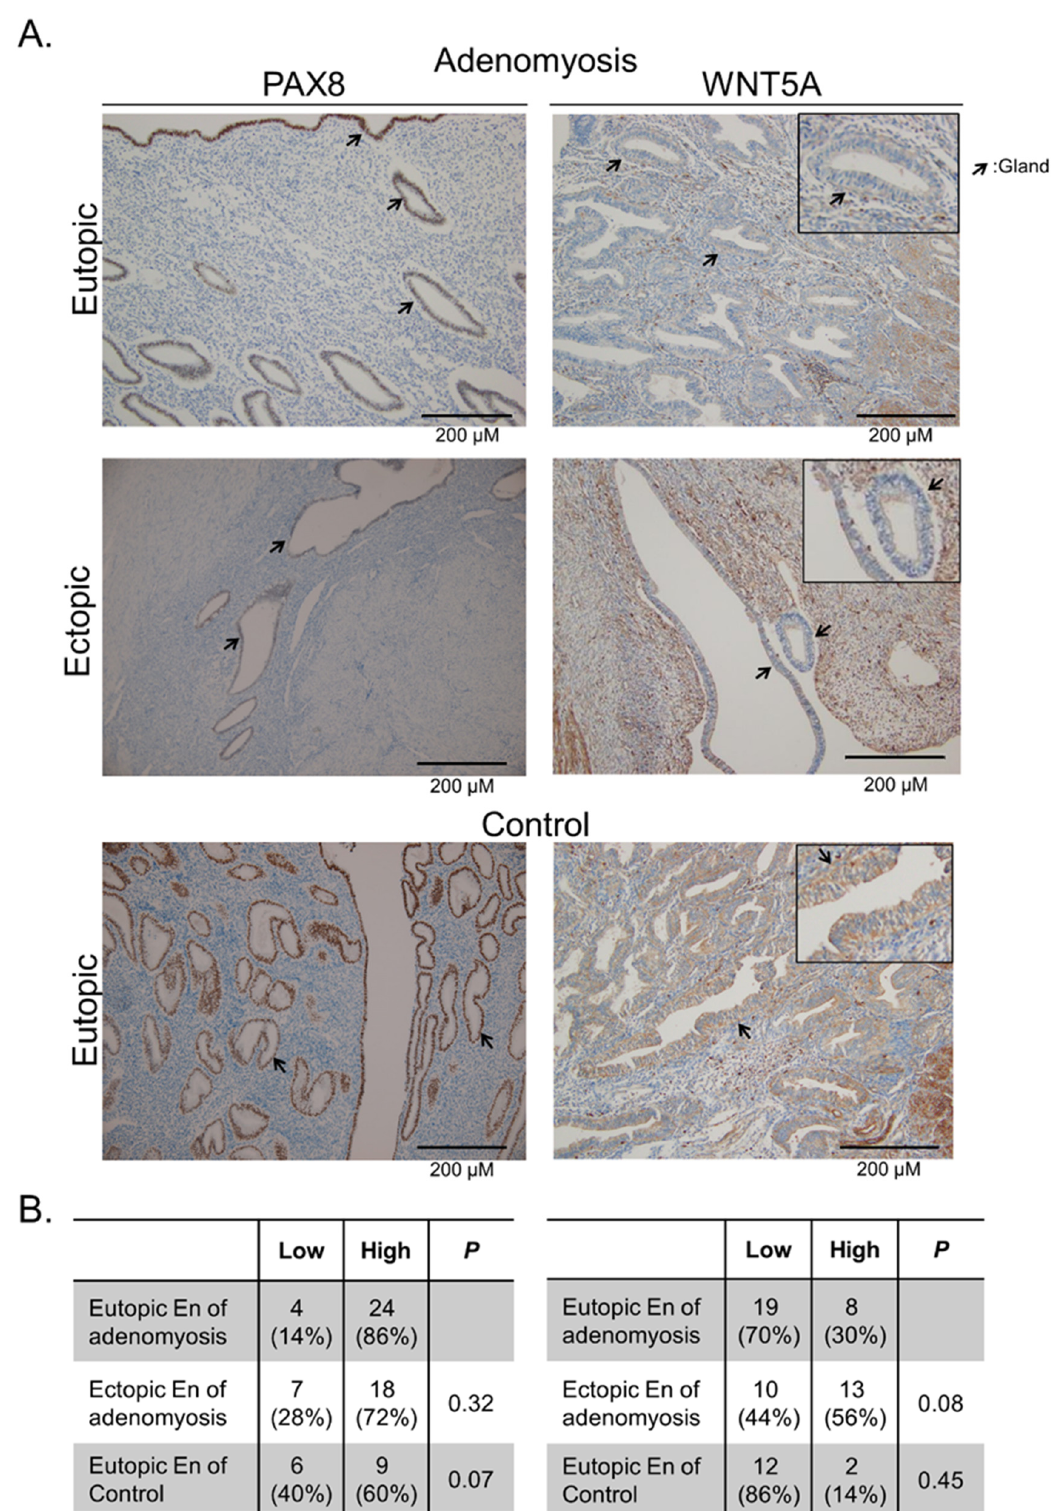
Figure 5. PAX8 and WNT5A in the eutopic and ectopic endometrium of patients with adenomyosis and controls. ( A ) Representative IHC staining of the PAX8 and WNT5A proteins. ( B ) Proportion of PAX8 and WNT5A intensity in the endometrial gland cells is shown. In the functional endometrium, high expression of PAX8 and WNT5A was shown. A lower percentage of WNT5A with low expression was detected in